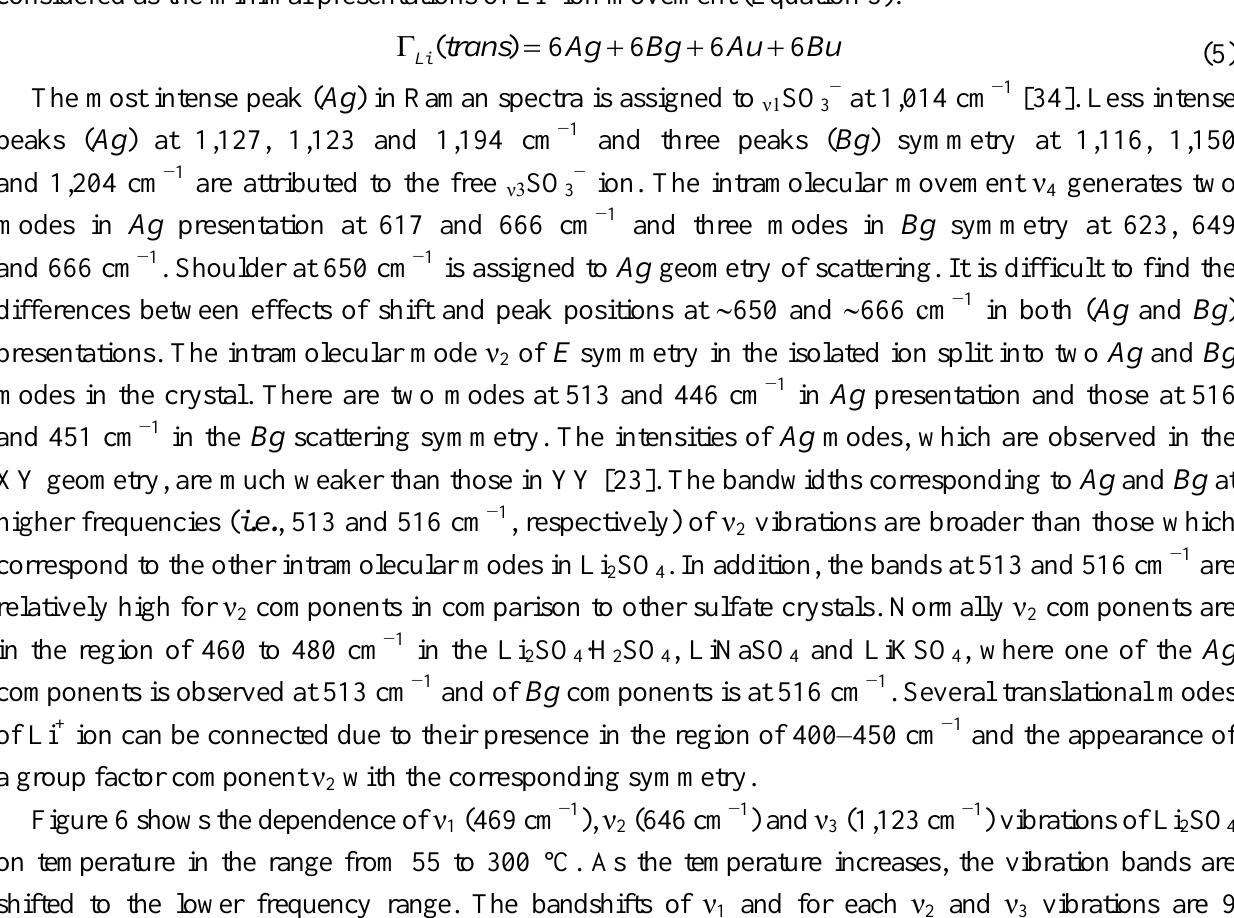
(646 cm −1 ) and ν 2